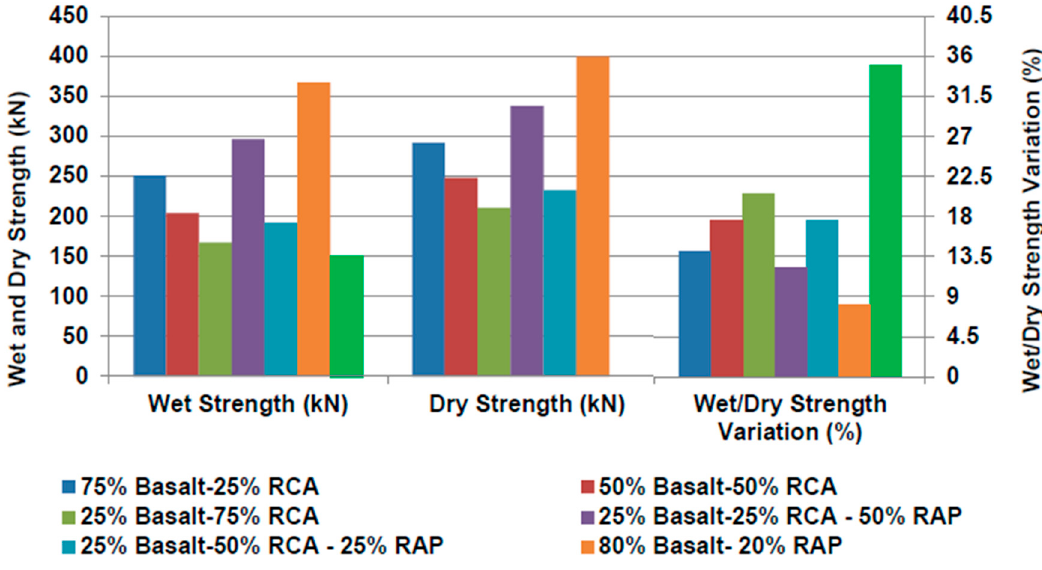
Figure 15. Comparison of the Wet Strength and Dry Strength of Different Mixes of Coarse Aggregates. Table 11. Summary of Tests Results for Evaluation of Mix of Coarse Aggregates Properties.